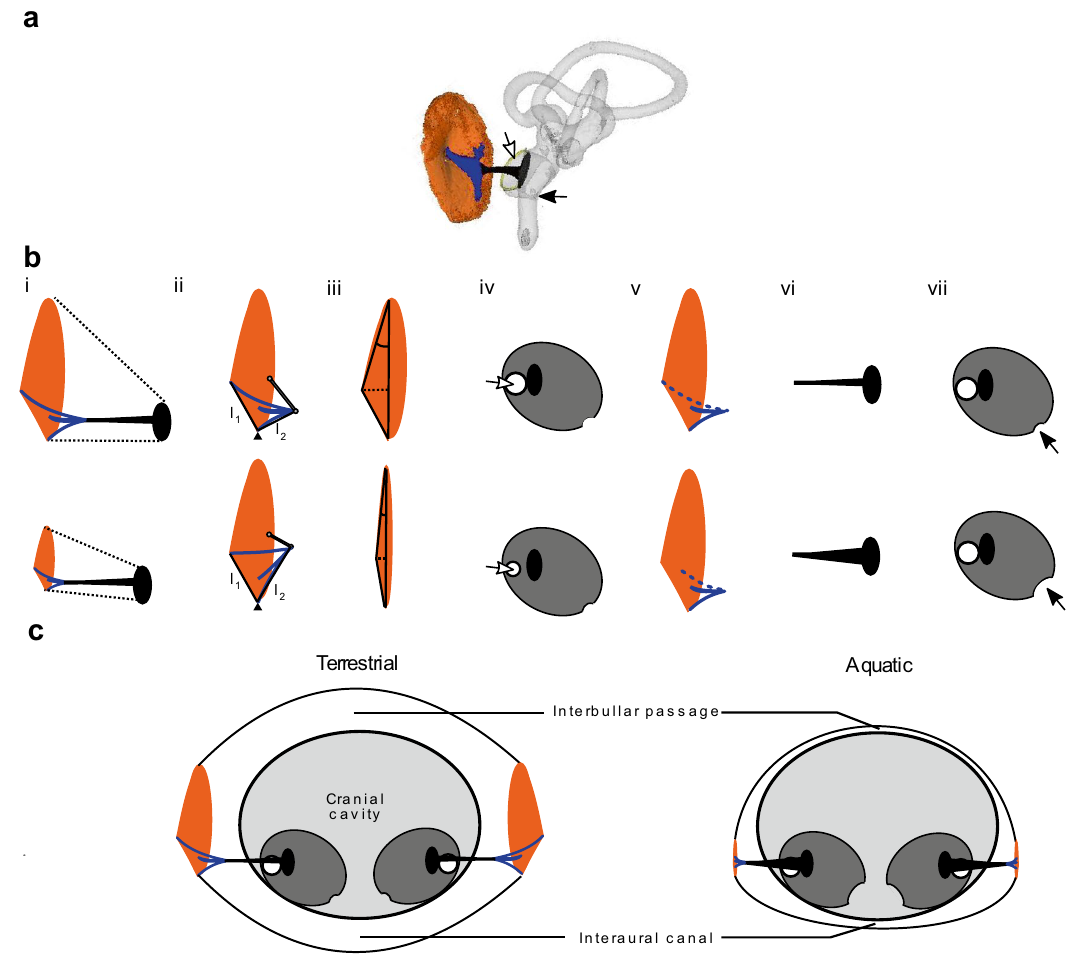
Figure 1. ( a ) Three-dimensional rendering of a typical terrestrial bird ear built from a micro-CT scan of a rock dove Columba livia , highlighting the tympanic membrane (orange), the trifurcated and cartilaginous extracolumella (blue), the columella bone (black), the inner ear (grey), the round window (white arrow) and cochlear aqueduct (black arrow). ( b ) Hypothesized anatomical differences between a bird ear typical of terrestrial species and thus adapted for aerial hearing (top row) versus one adapted for underwater hearing (bottom row). From aerial to aquatic, we expect (i) a reduction of the tympanic membrane-to-columella footplate area ratio (shown as a reduction in tympanic membrane area), (ii) a reduced offset (thin grey line) of the columella from the center of the eardrum, resulting in a smaller lever ratio (l 1 and l 2 indicate the lever arms), (iii) a flattened tympanic membrane, quantified as the height of the umbo and the angles at the periphery relative to the base plane of the tympanic membrane, (iv) a reduced area of the round window to raise total inner ear impedance, (v) a shorter extrastapedius, here used as a proxy of overall extracolumella stiffness (dotted line), (vi) hypertrophication of the columella, and (vii) enlargement of the cochlear aqueduct (represented by a curved indentation). ( c ) Summary of hypothesized differences in the ear of terrestrial (left) vs aquatic birds (right), combined with expectation of reduced cranial air and connectivity, interaural canal and interbullar passage between the two